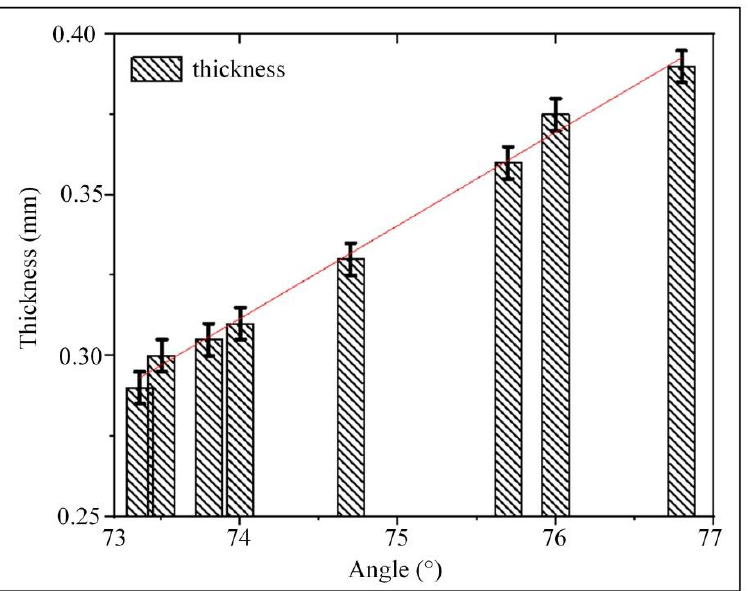
Figure 6. The relationship between the vessel wall thickness and contact angle. The resulting data were fitted using the least squares method to obtain the relationship between vessel wall thickness and contact angle ( n = 9) The thickness of the vessel wall was proportional to the contact angle, and with the increase of the contact angle, the thickness of the vessel wall gradually became thicker.